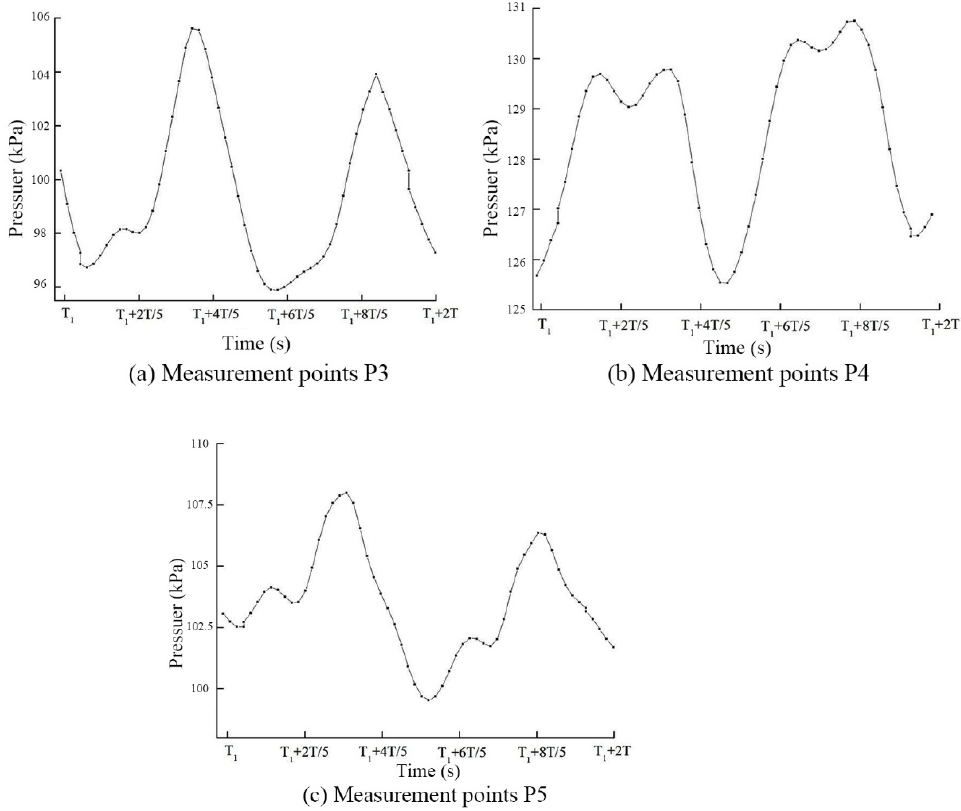
Figure 11. Pressure time domain diagram of P3, P4 and P5 at 6278 rpm. ( a ) P3; ( b ) P4; ( c ) P5. Further, the resonance characteristics of the blade were analyzed by extracting the displacement response and stress response of the blade. Figure 12 shows the variations in the displacement at the tip of the blade’s leading edge with a frequency under the six typical operating conditions using FFT (fast Fourier transform), where the horizontal axis represents the frequency, and the vertical axis represents the displacement. The blade exhibited different response characteristics at the different rotational speeds. However, all frequency–displacement curves have multiple peaks. At low rotational speeds (6278 and 6966 rpm), the blade resonated at the first-, second-, and fifth-order frequencies. At rotational speeds of 8847 and 9172 rpm, the displacement peaked mainly at the first- and second-order frequencies. At rotational speeds of 9337 and 9561 rpm, the blade resonated at the first-, second-, and third-order frequencies. For the frequency spectra at different rotational speeds, the maximum peak corresponded to the first-order frequency, and was thus a low-frequency vibration. The harmonic response at the second-order torsional frequency was also of high magnitude. As the rotational speed increased, the blade became less subject to resonance or harmonic resonance at high-order frequencies. Therefore, the vibration of the compressor blade was the result of the stacking of the vibrations at different orders of low frequencies [38–40]. Despite the different resonance response characteristics at different rotational speeds, the low-frequency (first-and second-order frequencies) modes of vibration were more easily excited than the high-order modes of vibration. Thus, the torsional deformation increases the complexity of the stress state in the blade and is non-negligible in subsequent stress and fatigue